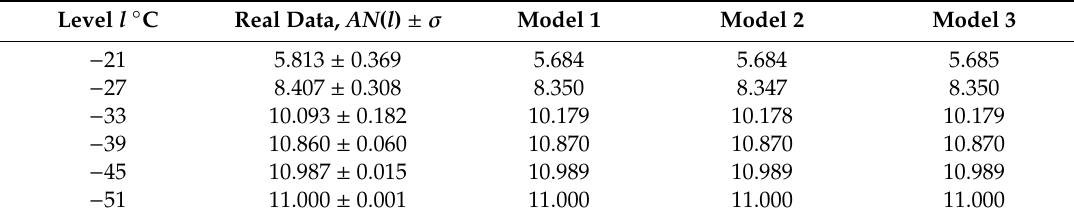
Table 2. The average number AN ( l ) of stations in the area where the average daily WCI was above the given level l , Area 2, 15 January.